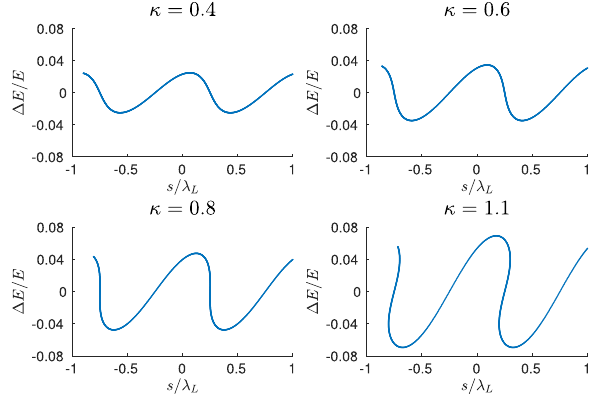
FIG. 8. The development of a nonsinusoidal energy modulation inside of the modulating undulator. The energy modulation normalized to the total beam energy is shown against the longitudinal coordinate scaled to the laser wavelength. We begin to see the folding over of phase space for κ ≳ 1